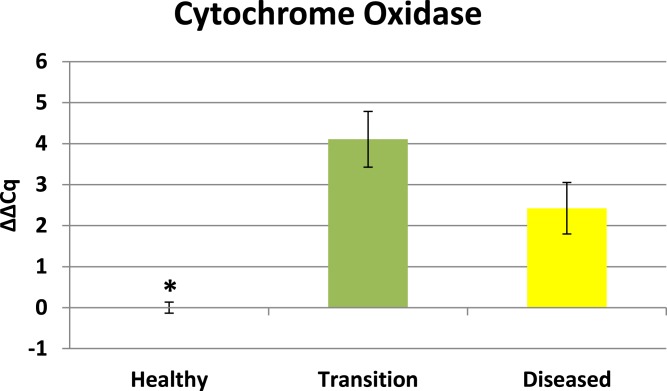
Expression of zooxanthellae Cytochrome Oxidase.The ΔΔCq values represent transformed expression of cytochrome oxidase relative to PABP expression. An * represents a condition that was significantly different in expression (P < 0.01) relative to other conditions. Error bars represent ± SE.